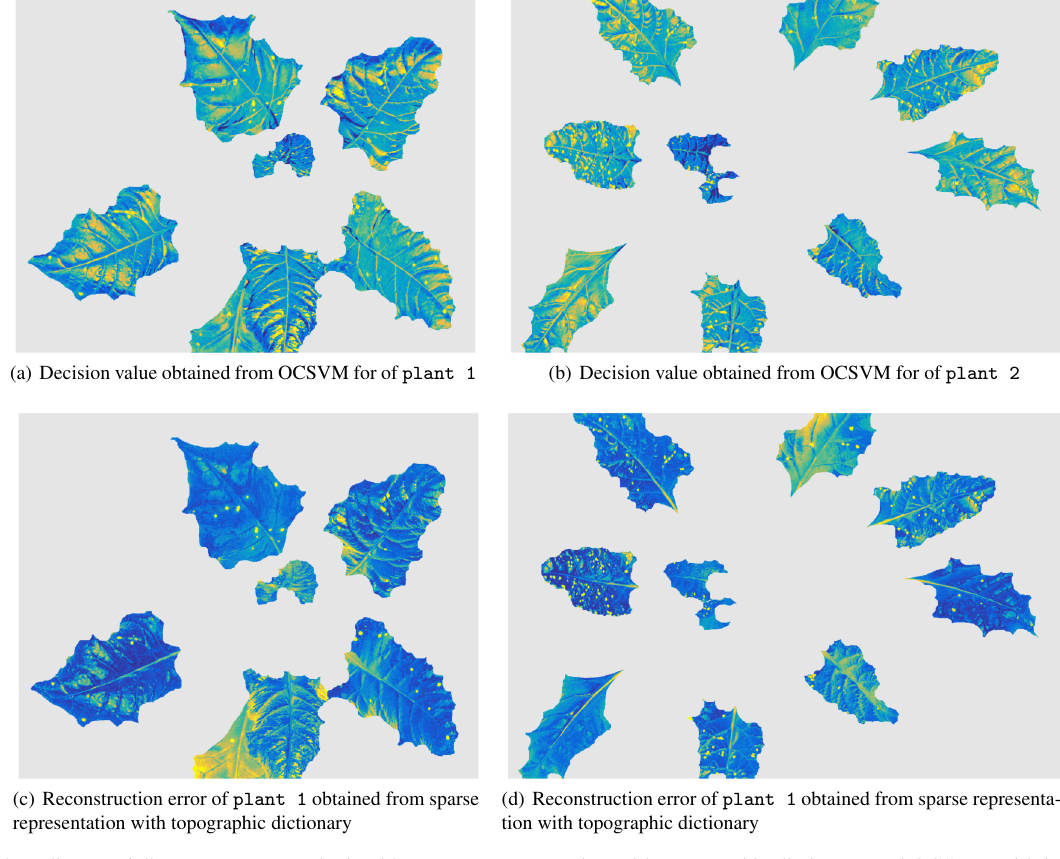
Figure 4: Indicator of disease symptoms obtained by sparse representation with topographic dictionary and OCSVM with inclination information. Blue color indicate a low value and yellow colors a high